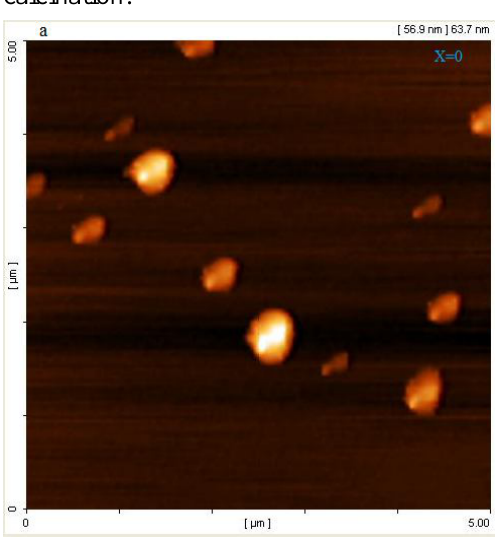
Fig. 4. AFM images for NiO nanoparticle before calcination.